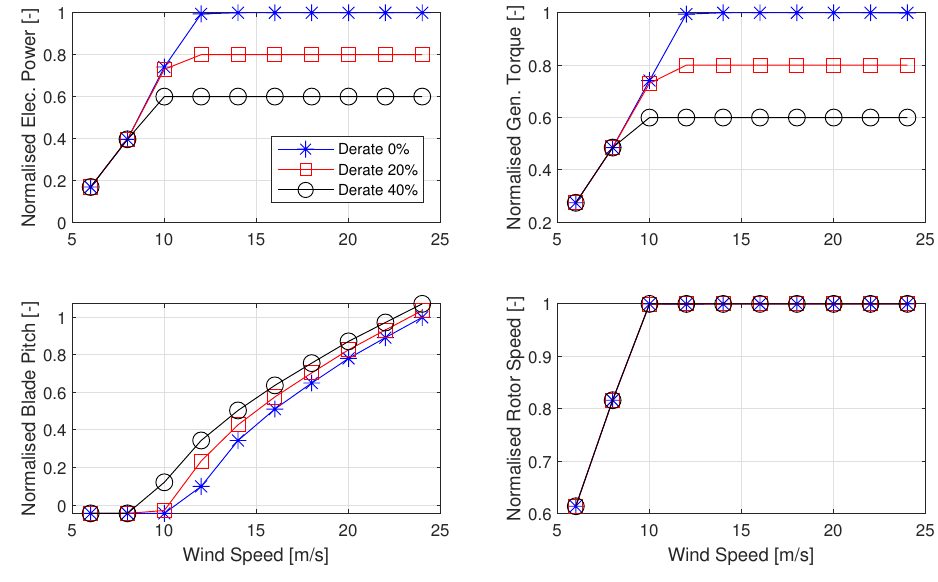
Figure 4. Normalised wind turbine mean electrical power, torque, blade pitch and rotor speed curves as a function of wind speed for different derating